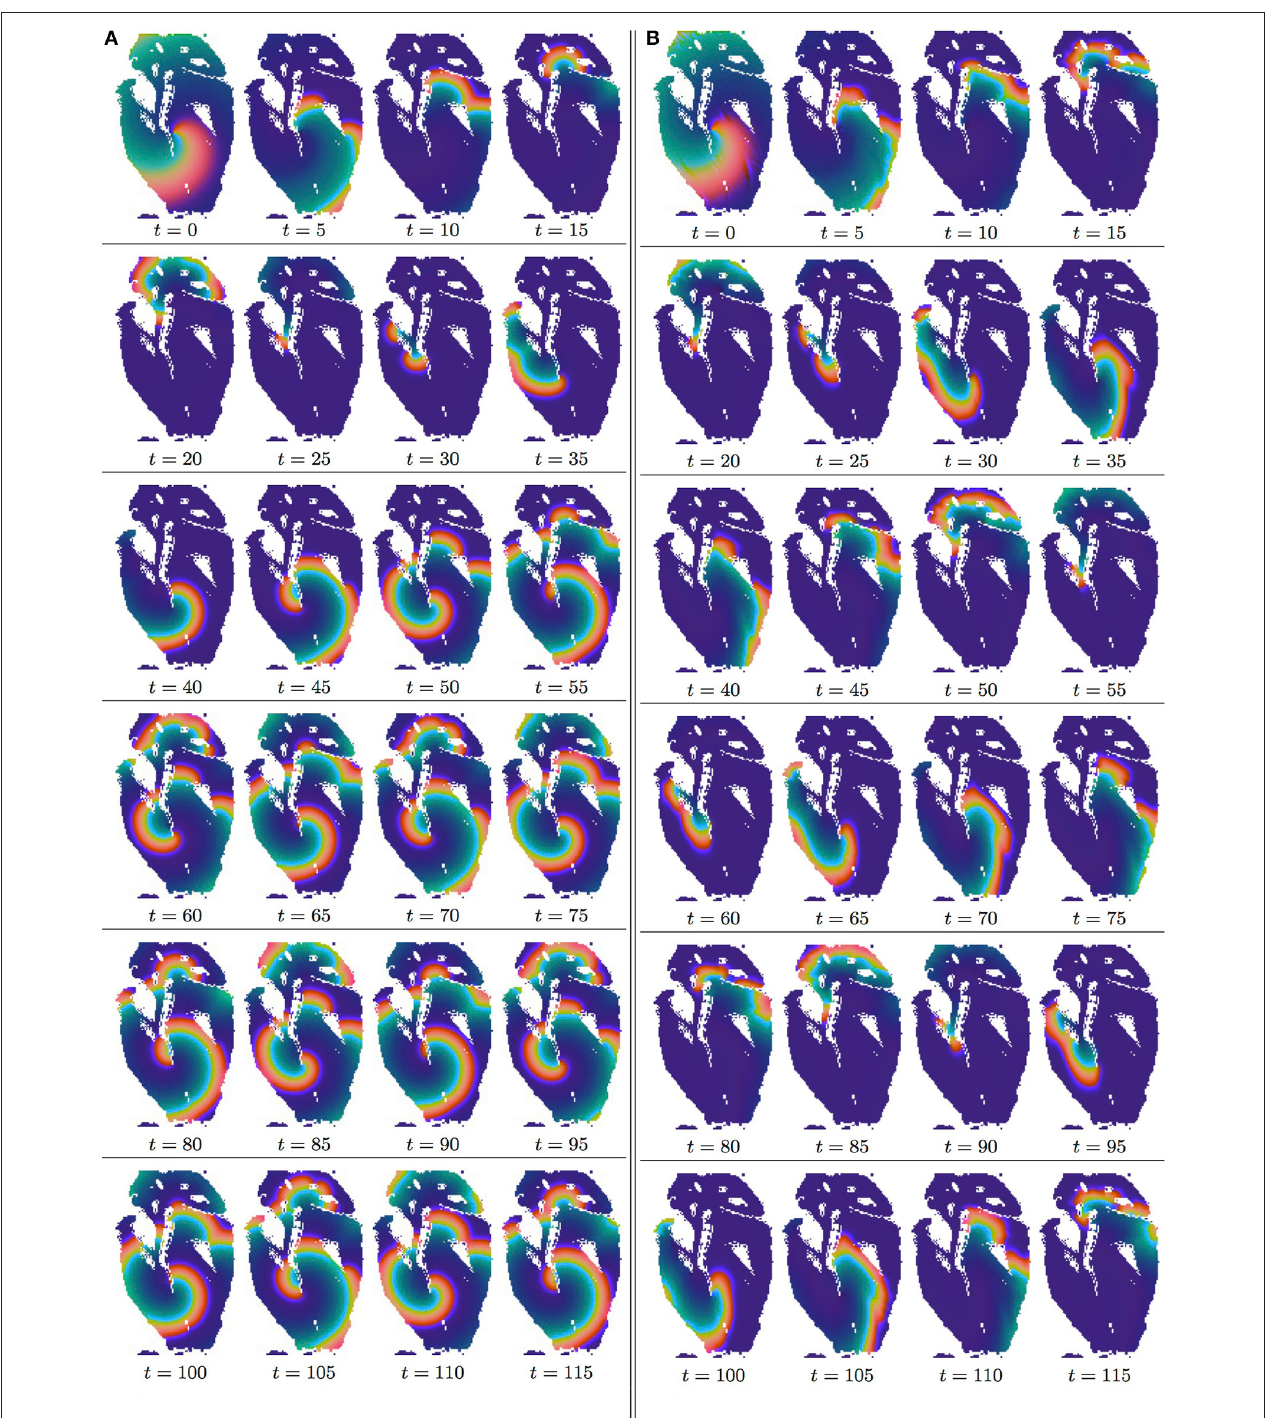
FIGURE 2 | Anisotropy effect in the 2D slice simulations, time shown under each panel in time units of Equations (1, 2). (A) Isotropic conduction : after the transient first rotation around the septum cuneiform opening, the slow excitation re-entry pins to the sharp low end of the opening in the fetal heart (See Supplementary Video 1 ). (B) Anisotropic conduction : after the fast transient first rotation around the septum cuneiform opening, the anisotropy of the fetal heart turns the initial spiral wave into the fast anatomical re-entry around the septum cuneiform opening (See Supplementary Video 2 ).